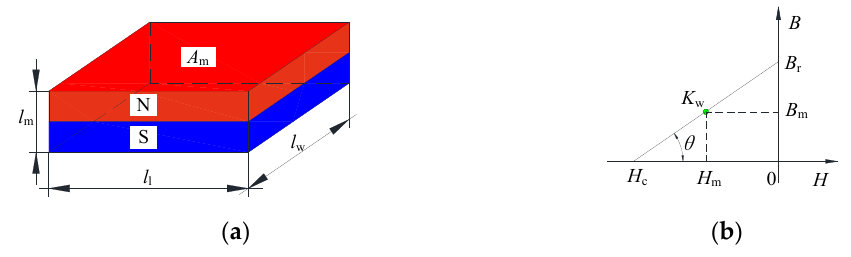
Figure 5. A schematic of the permanent magnet and its demagnetization curve. ( a ) The dimension and magnetizing direction; ( b ) the demagnetization curve.